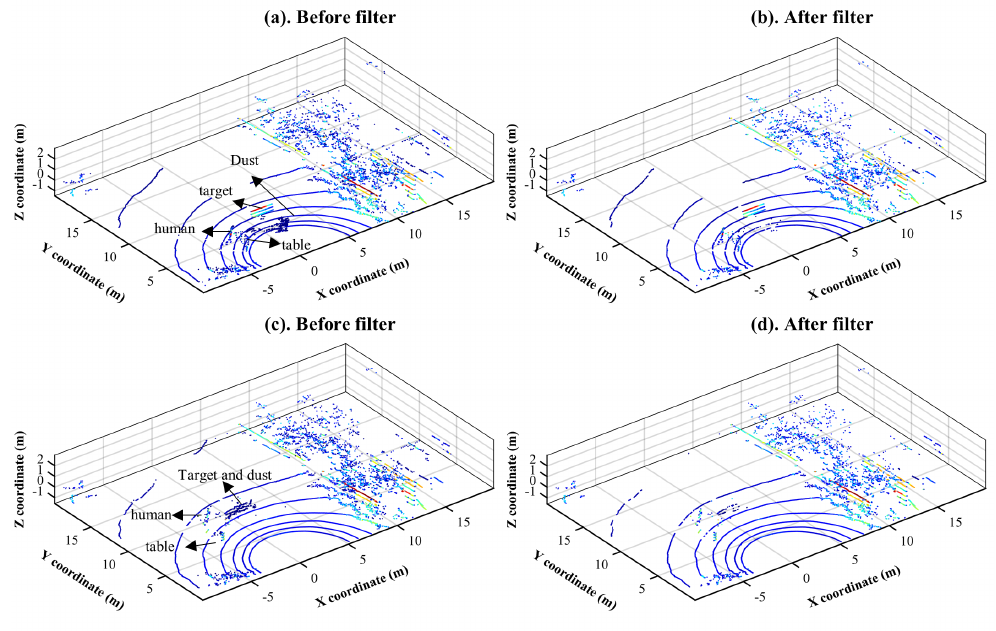
Figure 6. Experimental results after applying the developed LIDROR de-dusting filters in two different scenarios: point-cloud map before filtering in case of experiment No. 1, first scenario ( a ); point-cloud map after LIDROR filtering in case of experiment No. 1, first scenario ( b ); point-cloud map before filtering in case of experiment No. 3, second scenario ( c ); and point-cloud map after LIOR filtering in case of experiment No. 3, second scenario ( d ).